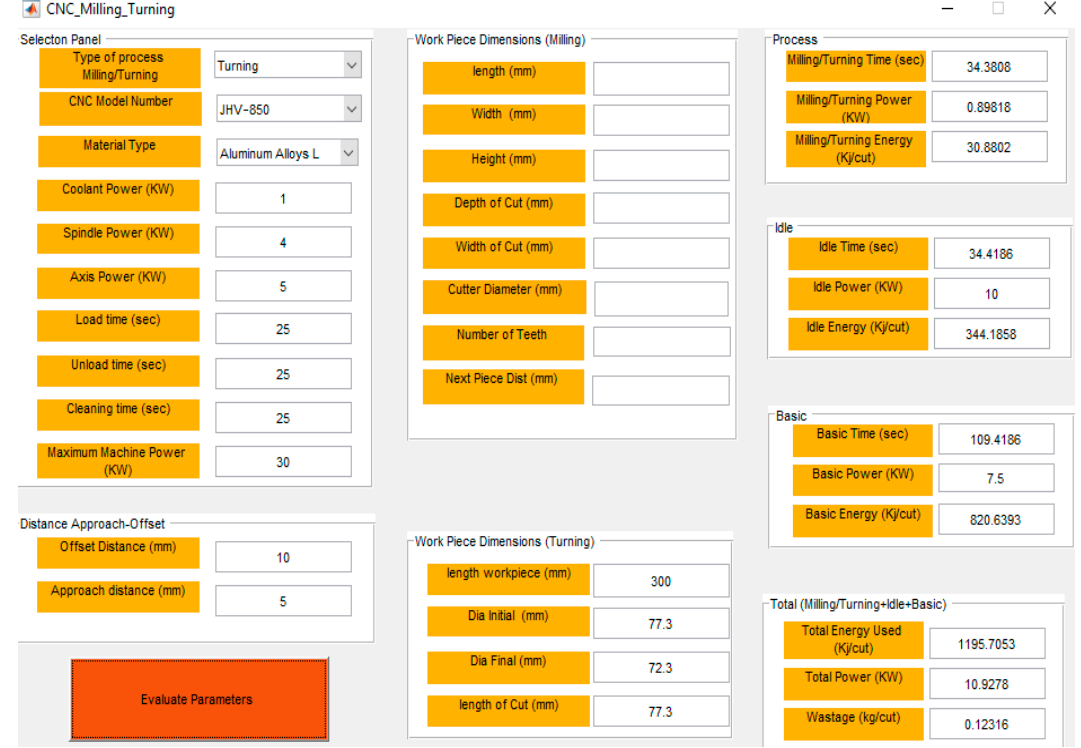
Figure 5. A GUI showed both inputs (column first and second) and outputs (column 3) for the turning